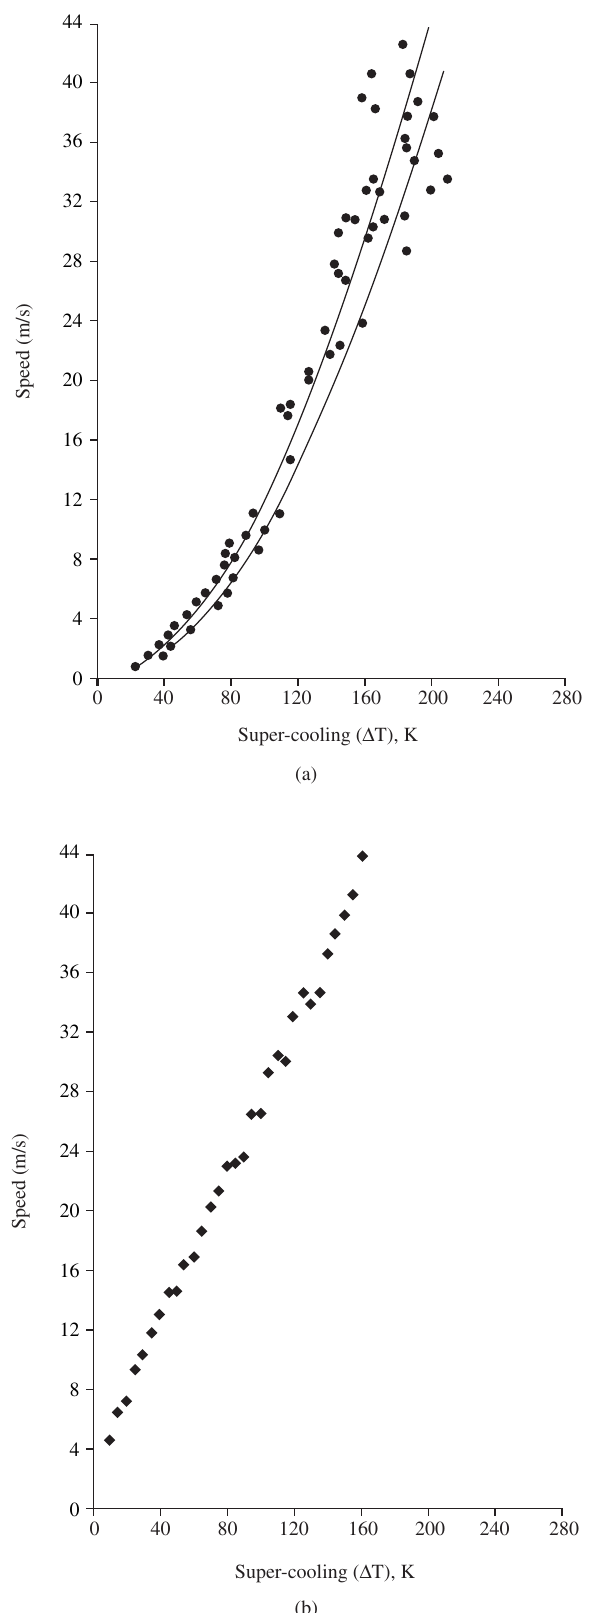
Figure 5. Dendrite tip speed vs. thermal supercooling ( D T), a) experimental 17 ; and b) predicted in this work using the phase-field model.